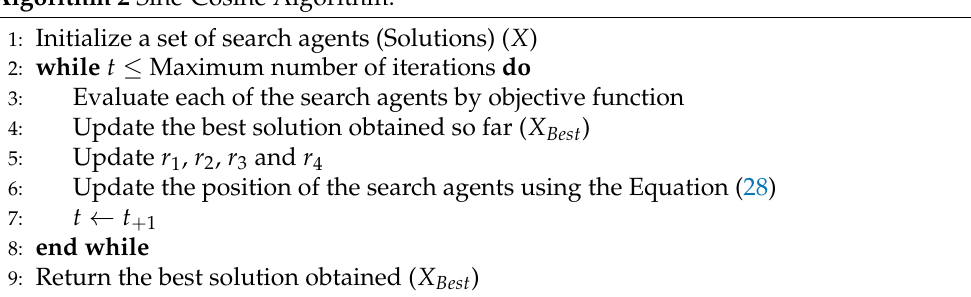
Algorithm 2 Sine-Cosine